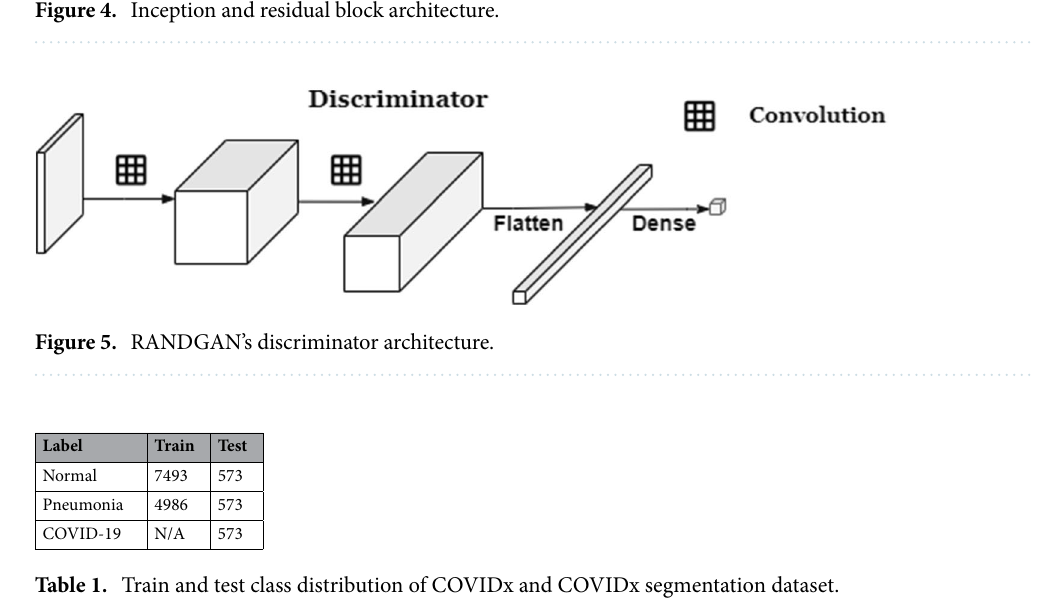
Figure 4. Inception and residual block architecture.